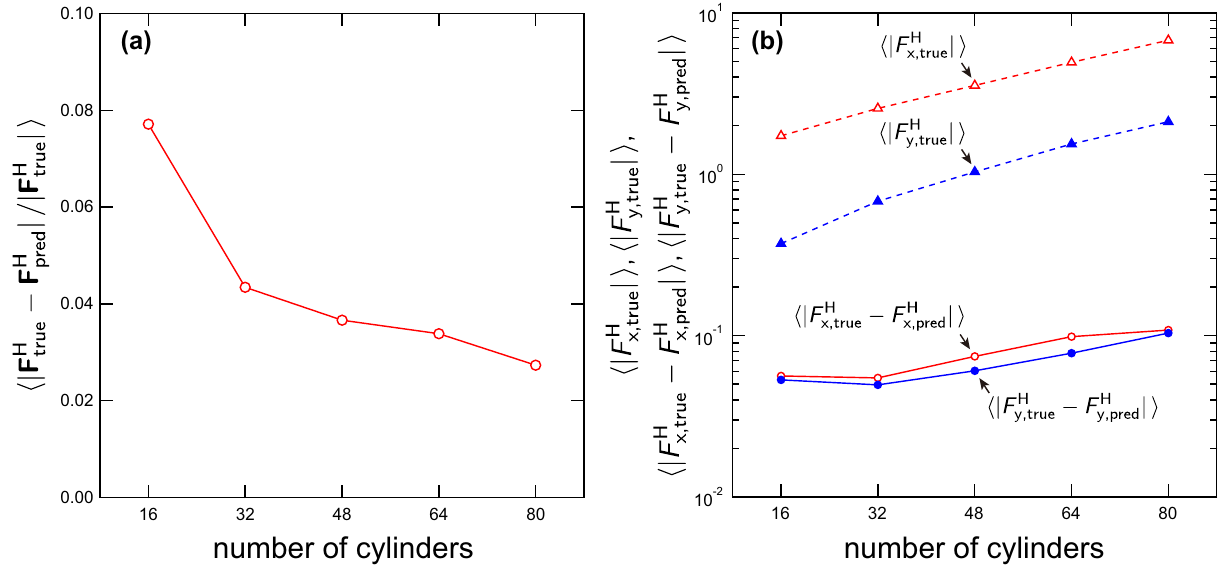
F H F H F H / true |� as a function of the true − pred | | �| F H F H x,true − x,pred |� �|